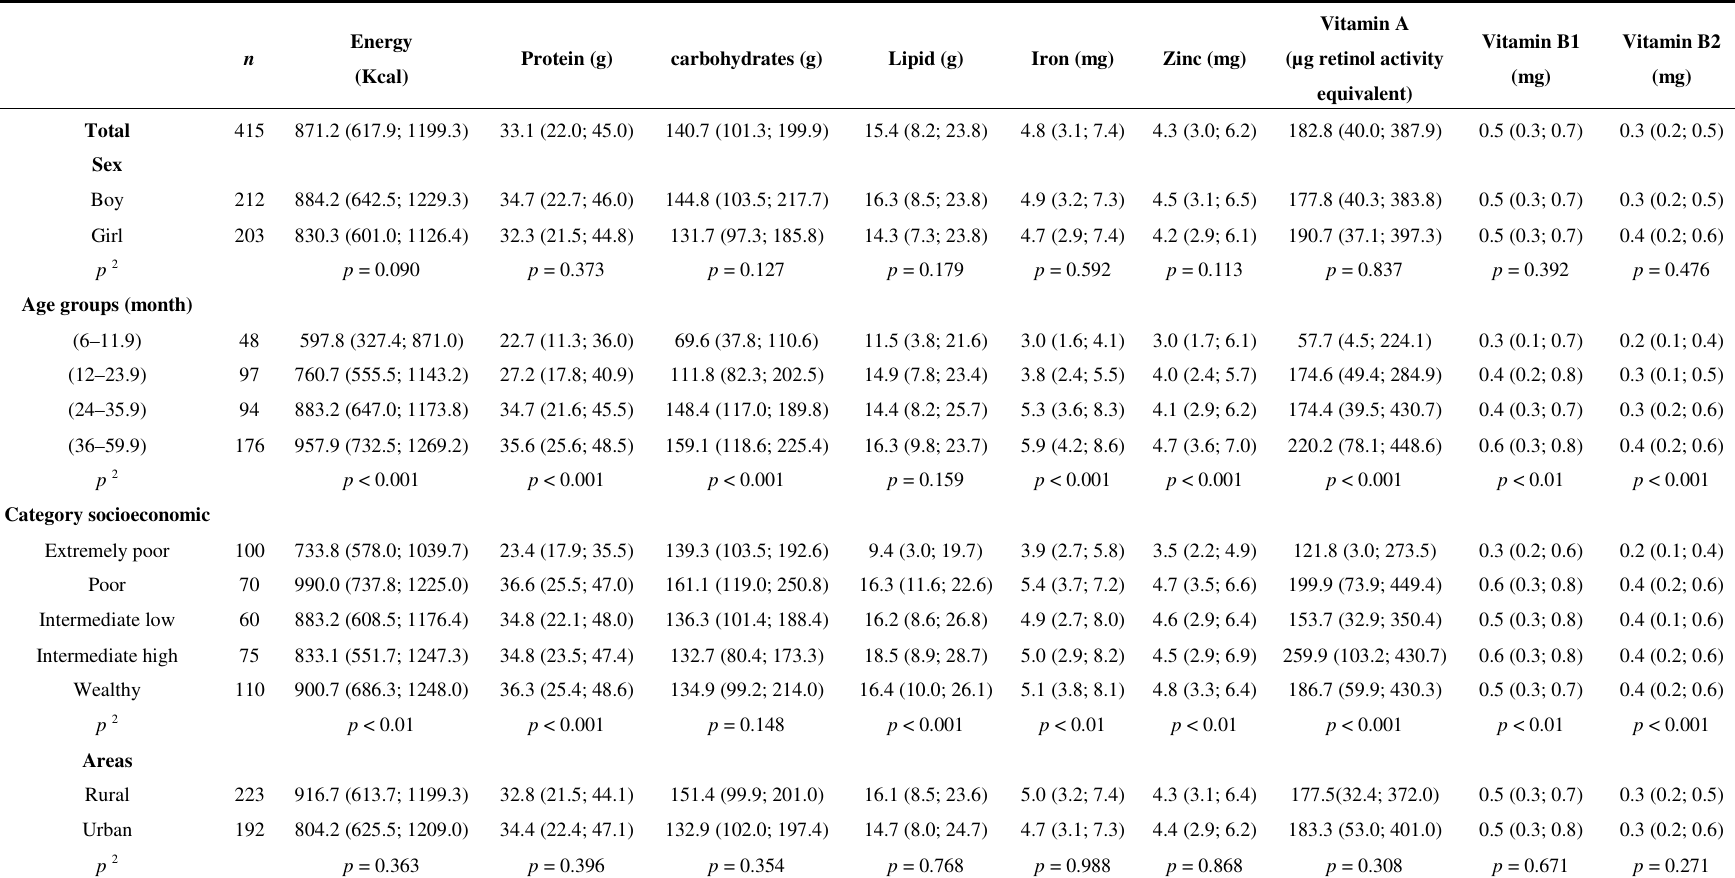
Table 2. Macro- and micronutrient intake (in g/capita/day) by rural and urban residence, sex, age group and socioeconomic group (median and 25th, 75th percentile) 1,2,3,4